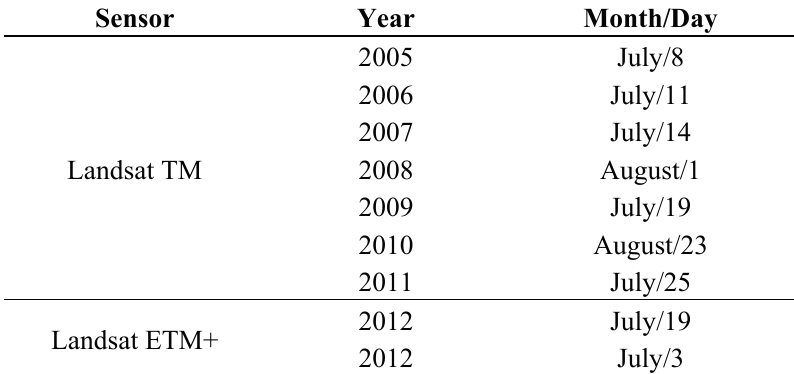
Table 1. The sensor name and date of acquisition of remotely sensed scenes. Two scenes were acquired in 2012 to fill data gaps associated with the scan-line corrector failure on Landsat ETM+.